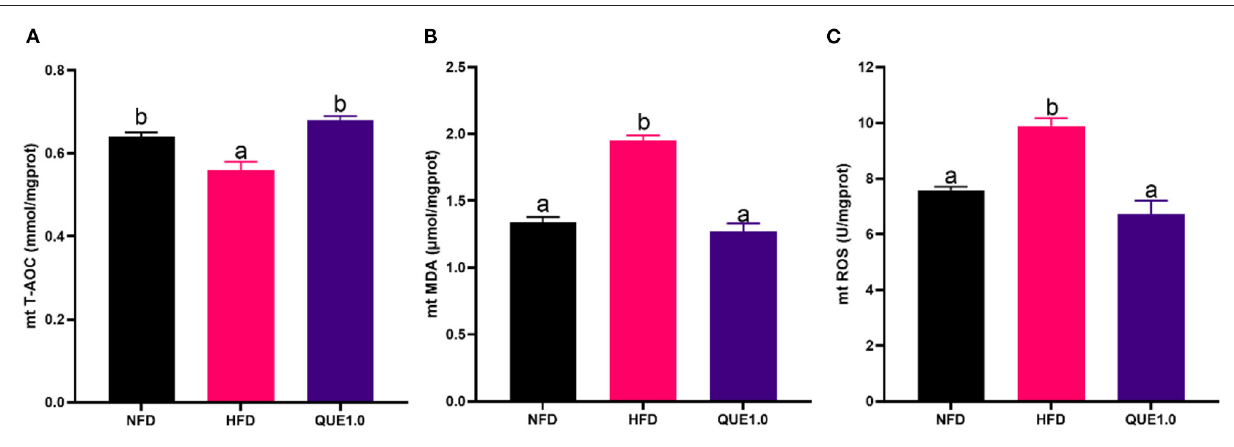
In mitochondrion, fish-fed HFD showed the lowest T- AOC and the highest contents of MDA and ROS. Meanwhile, the supplementation of 0.1% QUE significantly